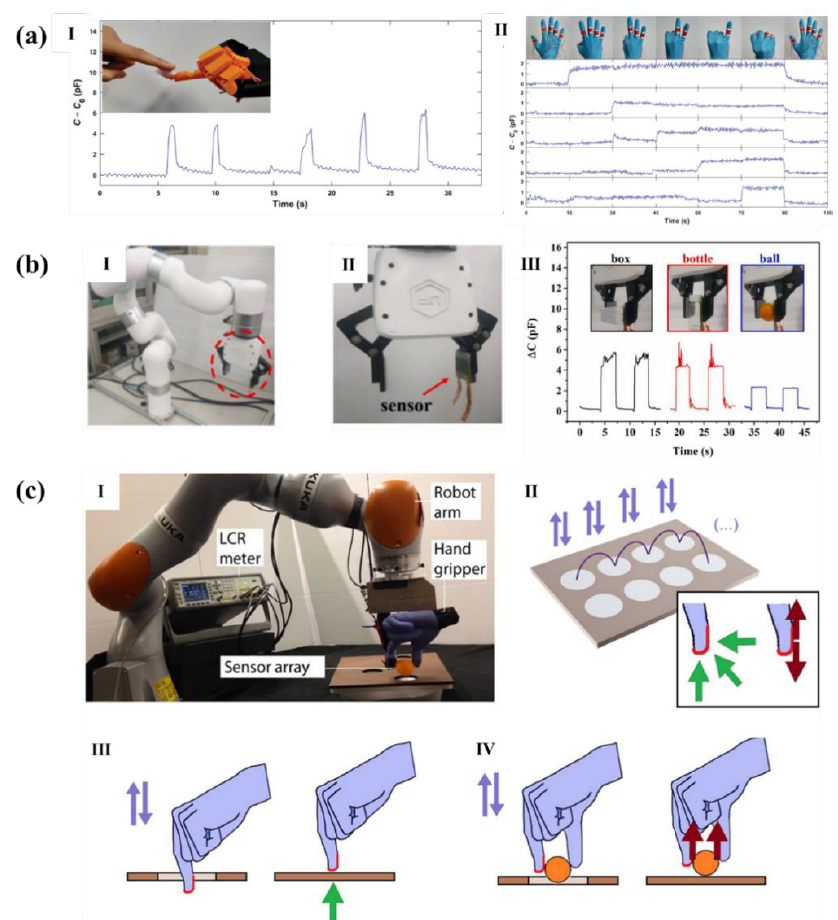
Figure 15. Micro structed flexible pressure sensors used in the electronic skin of robot.( a ): ( I ) The sensor mounted on a robotic hand; ( II ) Five sensors mounted on a nitrile glove, which can be used to distinguish between different hand gestures. [120]. ( b ): ( I ) Digital photo of the robotic arm; ( II ) Magnified view of the claw with an attached sensor; ( III ) The capacitive responses when the claw holds the box, bottle, and ball [52]. ( c ): ( I ) E-skin sensor array mounted on an artificial hand and fixed on a gripper attached to the robot arm; ( II ) Typical test plate with holes; ( III ) The artificial hand is used to recognize the test plate with hole or not; ( IV ) A ping-pong ball was positioned between the two artificial fingers. Purple arrows show the movement executed downward, unless shear (tangential) force feedback (dark red arrow) was detected and prevented the entire execution of downward movement. [99].